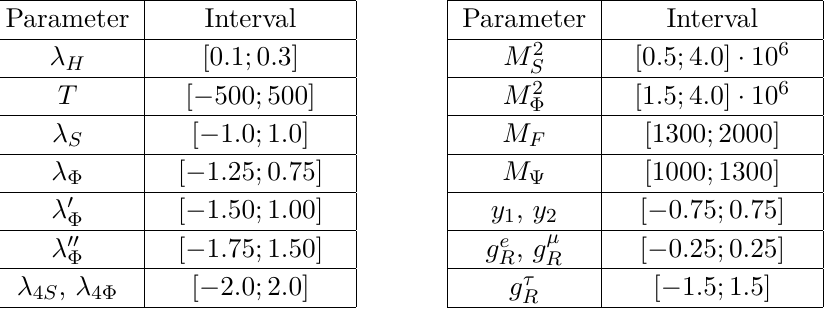
and g i ( i = e, µ, τ ) F Ψ